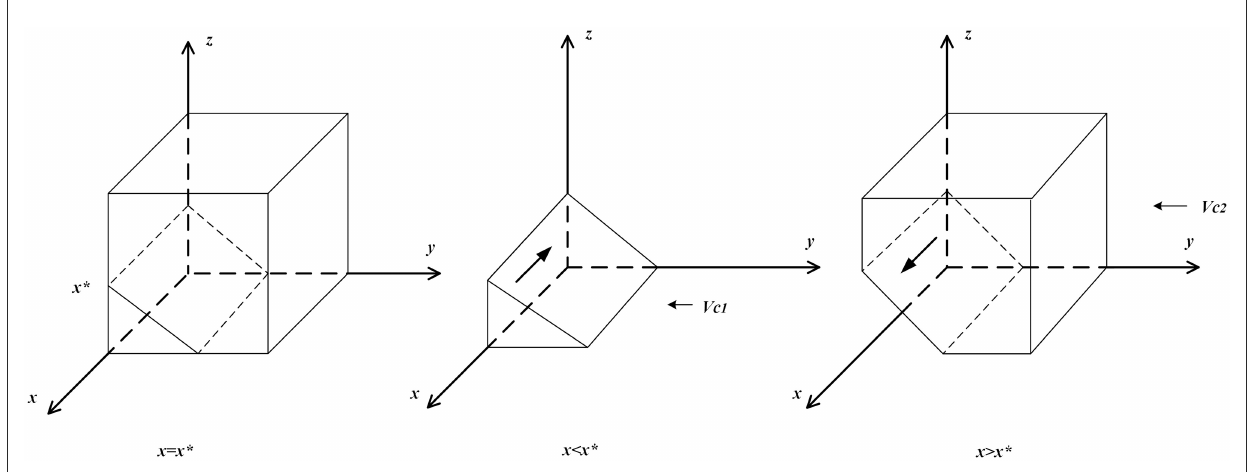
FIGURE3 Phase diagram of domestic enterprises’